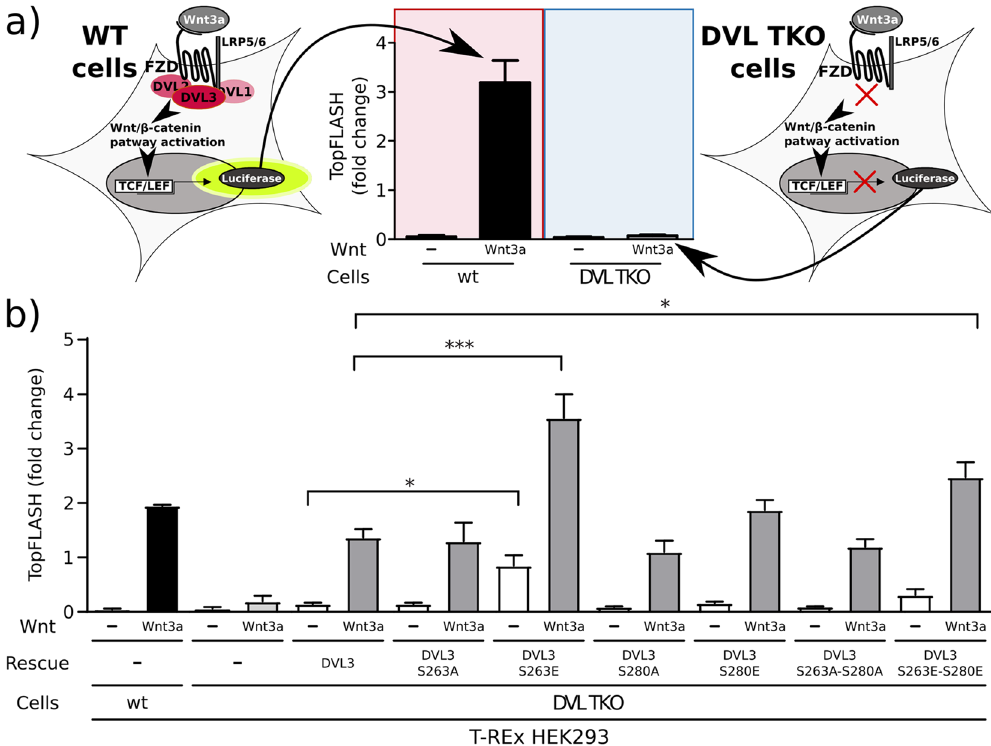
Figure 8. Rescue analysis in DVL triple knockout cells. ( a ) The illustration of the DVL3 rescue TopFlash assay where luciferase activity is measured after addition of Wnt3a ligand. If active DVL molecules are present in the cell a change of luminescence is measured. ( b ) The luciferase activity in different DVL3 mutants. All phosphomimicking (S–E) or phospho-preventing (S–A), used as a negative control, DVL3 mutants were able to rescue transcriptional response in DVL TKO cells induced by recombinant Wnt3a. However, DVL3 S263E and DVL3 S263E/S280E mutants were hyperactive upon Wnt-3a stimulation. Interestingly, DVL3 S263E behaved as constitutively active and activated TopFlash response even in the absence of Wnt-3a as analyzed by TopFlash assay, n = 3 with SEM indicated by error bars. The statistical differences were analyzed by paired Student’s t-test (* p < 0.05 , ** p < 0.01